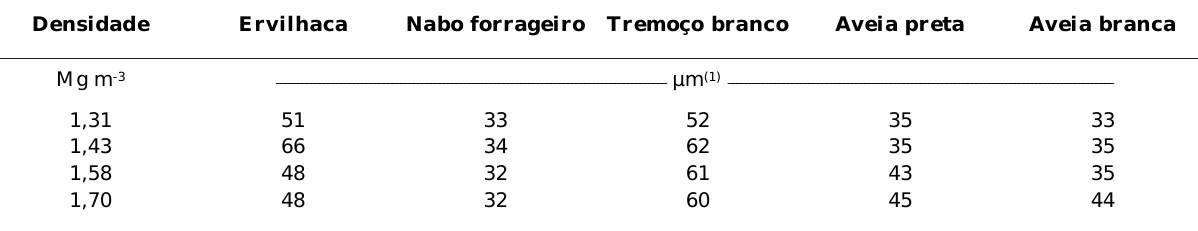
Quadro 4. Diâmetro médio radicular das plantas de adubo-verde de inverno na camada compactada do solo, considerando a densidade do